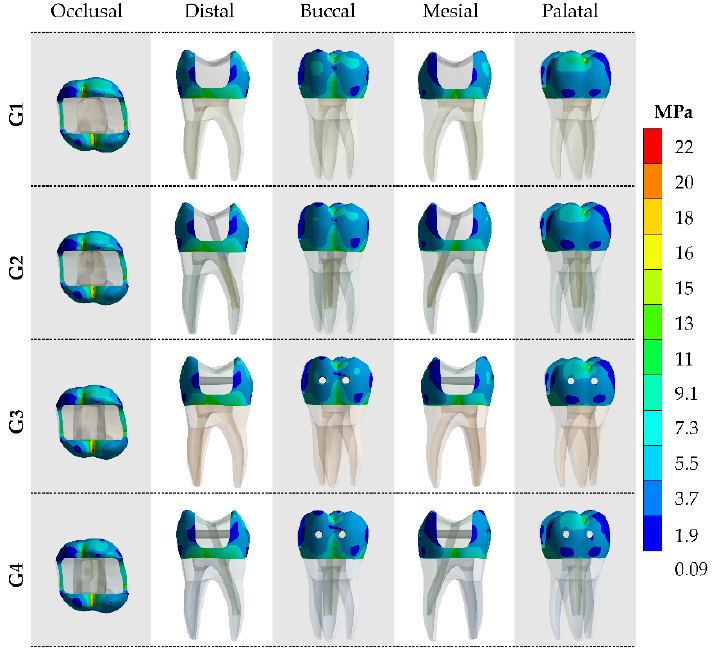
Figure 6. The von-Mises stress (MPa) concentration from five different viewpoints in the enamel tissue according to the GFP treatment.